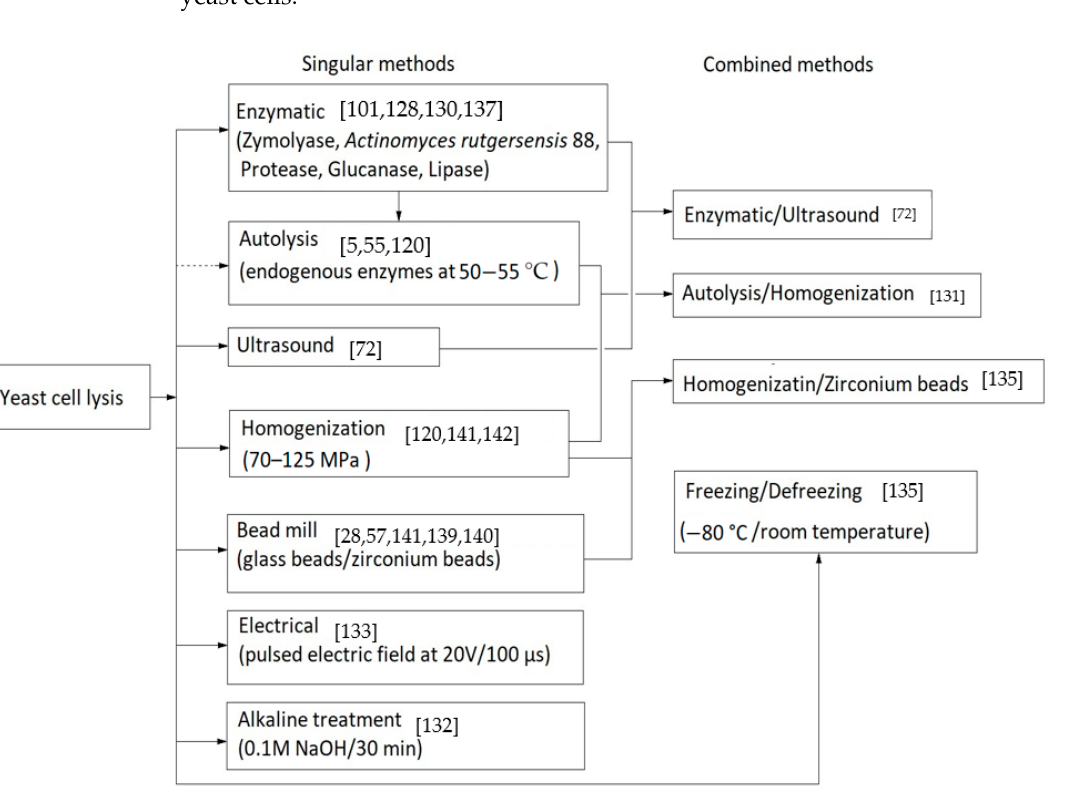
Figure 3. Different cell lysis methods for obtaining β -glucans.